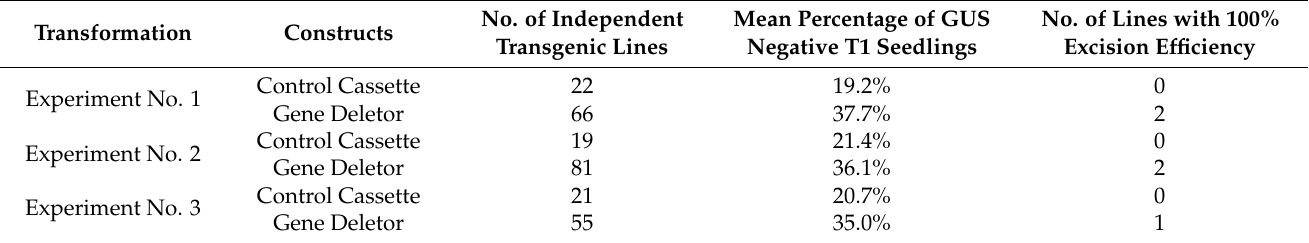
Table 1. Numbers of plants transformed with the control or ‘pollen- and seed-specific Gene Deletor’ cassettes and the corresponding transgene excision efficiency in the produced pollen and seeds, based on GUS activity levels in the T1 seedlings grown in the